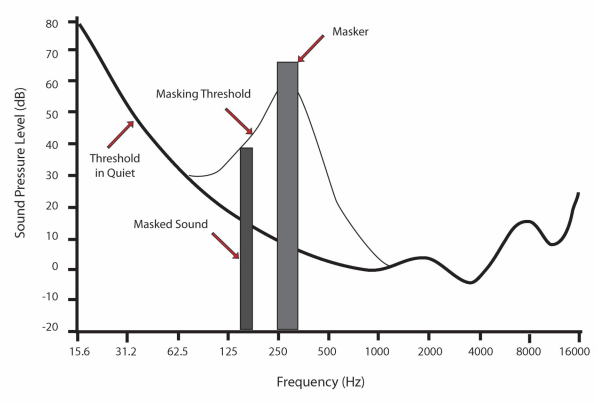
Figure 2: Masking effect of a pure tone